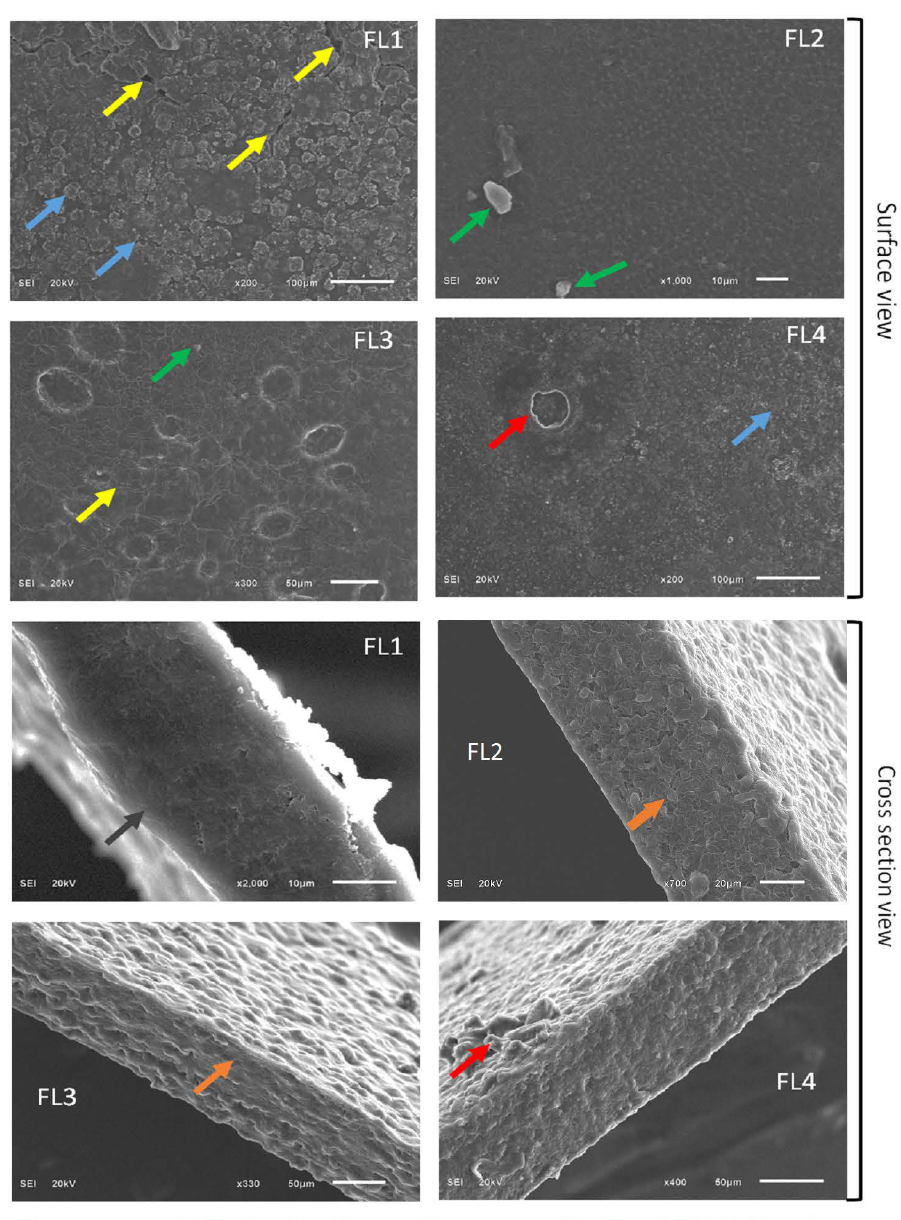
Figure 5. SEM analysis of FL1–FL4 composite films samples: control or FL1 (CA + SA); FL2: CA + SA + OEO (1.5% v / v ); FL3: CA + SA + OEO (2% v / v ); FL4: CA + SA + OEO (2.5% v / v